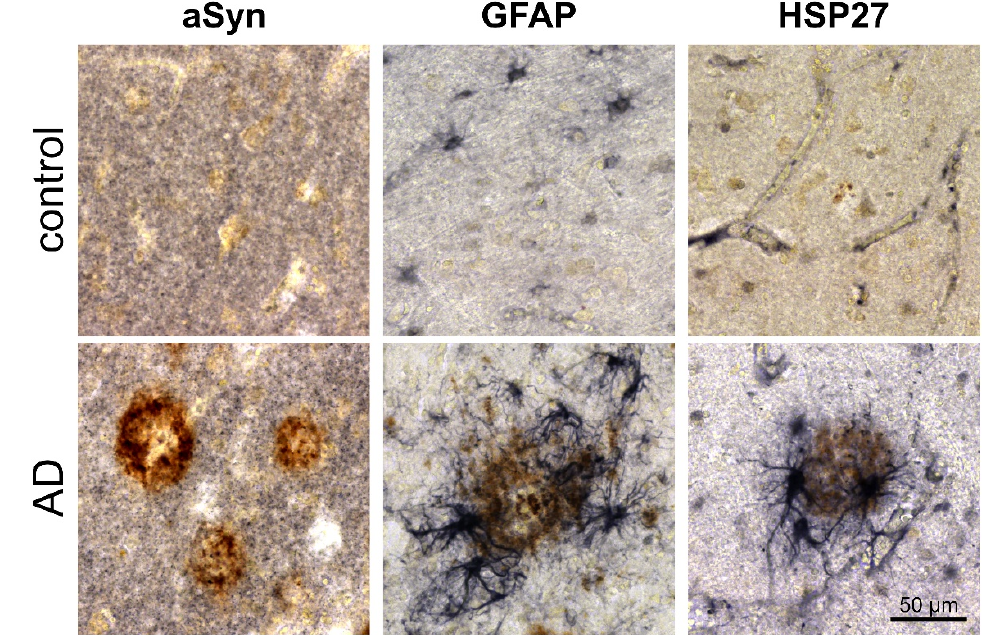
Figure 6. HSP27 expression by amyloid plaque-associated reactive astrocytes in human temporal cortex (Brodmann area 22). In control subjects ( top row ), synaptic aSyn labeling, GFAP-immunoreactive resting astrocytes and vascular HSP27 were detected (DAB-Ni, black). In AD ( bottom row ), strong activation of plaque-associated astrocytes and substantial astroglial HSP27 expression were evident. Full-length aSyn labeled by the 15G7 antibody, on the other hand, was not found to be enriched around A β plaques (DAB, brown) and was absent from reactive astrocytes.